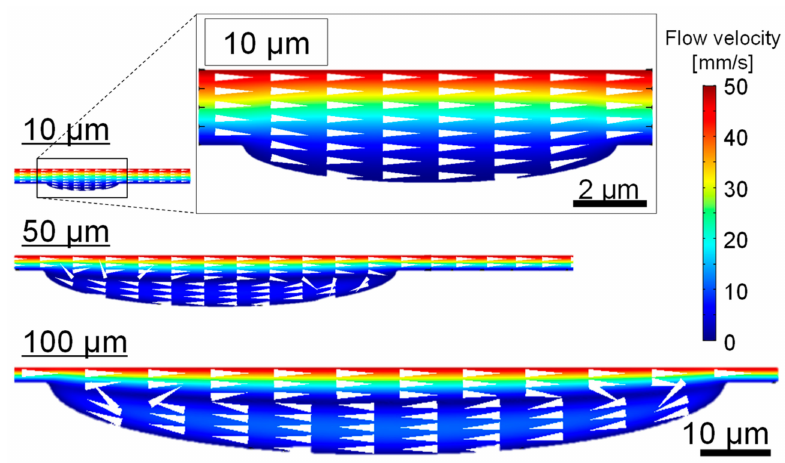
Figure 15. Comparison of the distribution of the lubricant flow velocity in the dimple cells with di ff erent diameters of 10 µ m, 50 µ m, 100 µ m under a lubricant film thickness of 2.0 µ m.